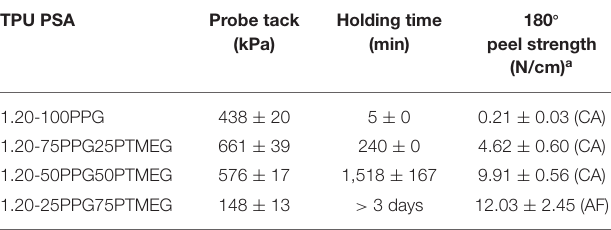
TABLE 8 | Probe tack at 25 ◦ C, holding time at 25 ◦ C, and 180 ◦ peel strength at 25 ◦ C of aluminum 5754/TPU PSA joints. TPU PSA Probe tack Holding time 180 ◦ (kPa) (min) peel strength (N/cm) a 1.20-100PPG 438 ± 20 5 ± 0 0.21 ± 0.03 (CA) 1.20-75PPG25PTMEG 661 ± 39 240 ± 0 4.62 ± 0.60 (CA) 1.20-50PPG50PTMEG 576 ± 17 1,518 ± 167 9.91 ± 0.56 (CA) 1.20-25PPG75PTMEG 148 ± 13 > 3 days 12.03 ± 2.45